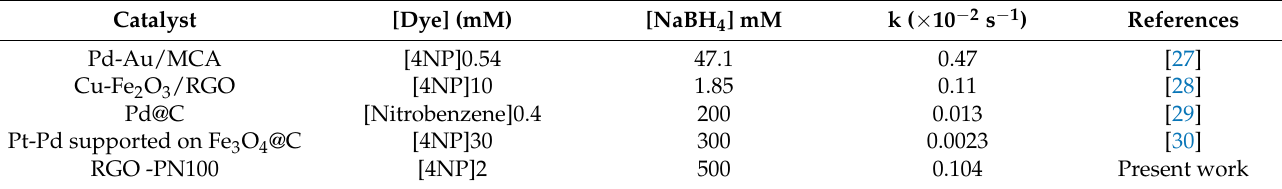
Figure 6. ( a ) Degradation kinetics of 4-nitrophenol using green synthesized RGO-PN100 from Coleus amboinicus ( b ) plots of reaction time versus Log (C t /C 0 ). Table 1. Comparison of rate of reaction constant (k) with recent literature.